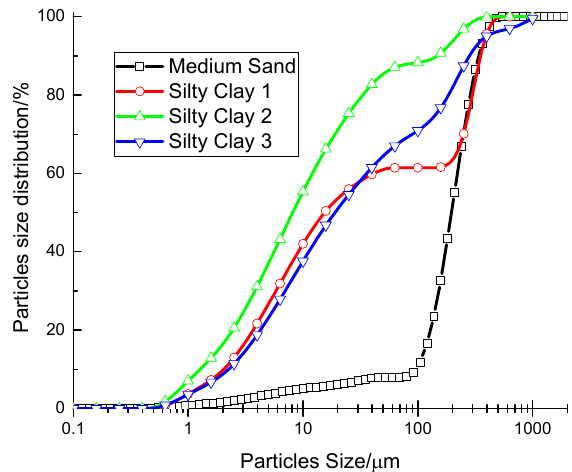
Figure 3. The particle size distribution of the sand.